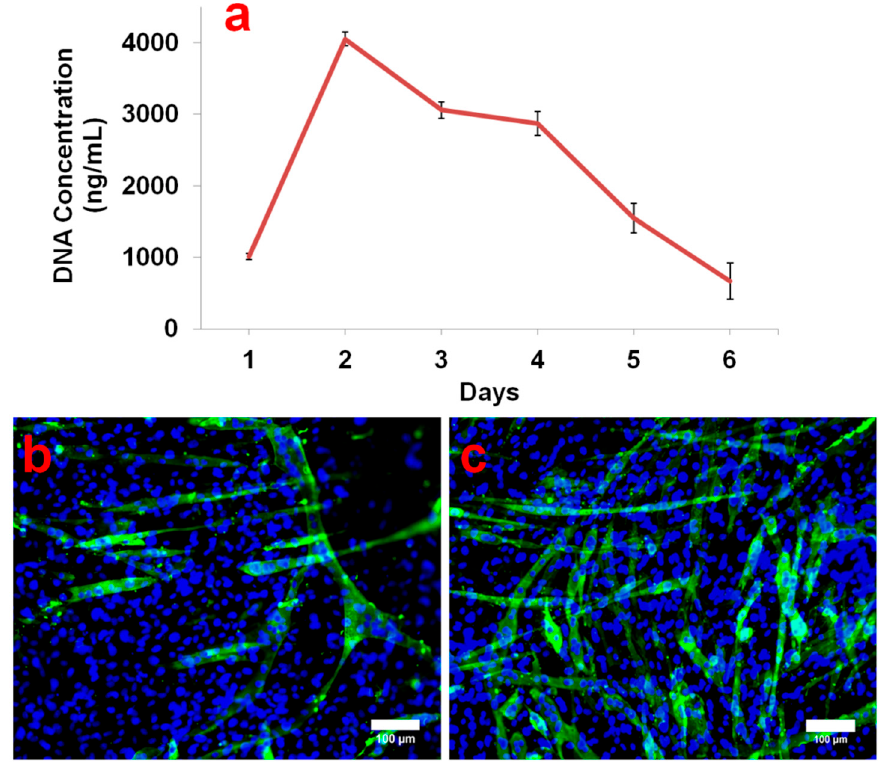
Figure 6. ( a ) DNA concentration of C2C12 myoblasts found at different time intervals in PicoGreen assay; ( b ) MHC staining (green) displayed myotube formation on PCL membrane after 4 days of cell seeding; ( c ) Positive control demonstrates induction of myotube formation in C2C12 myoblasts grown in DMEM containing 2% horse serum.